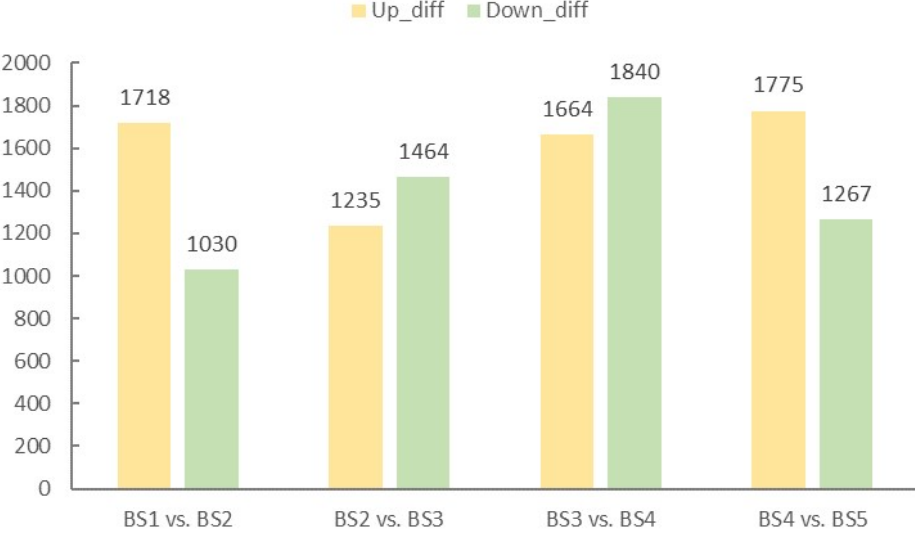
Figure 4. The number of differentially expressed genes among the four groups of samples. The horizontal axis represents the comparison group; the vertical axis represents the number of DEGs, and the yellow and green bars represent up- and downregulated genes, respectively.